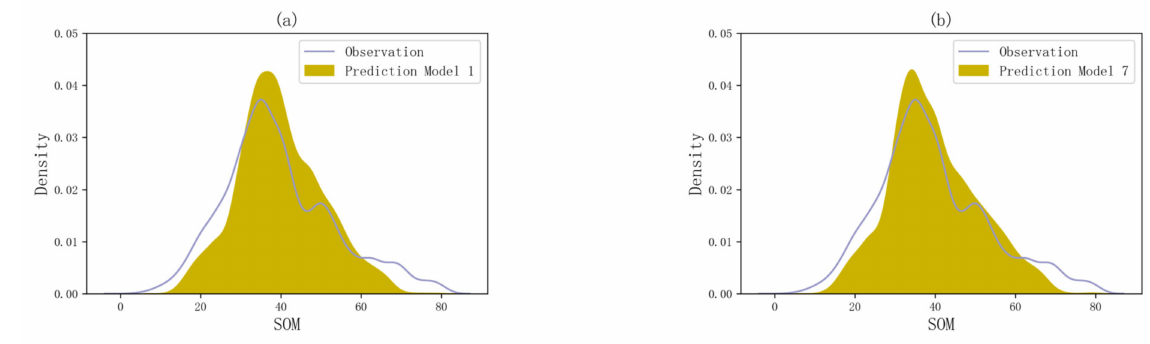
Figure 6. Density distribution of SOM predicted with Model 1 ( a ) and Model 7 ( b